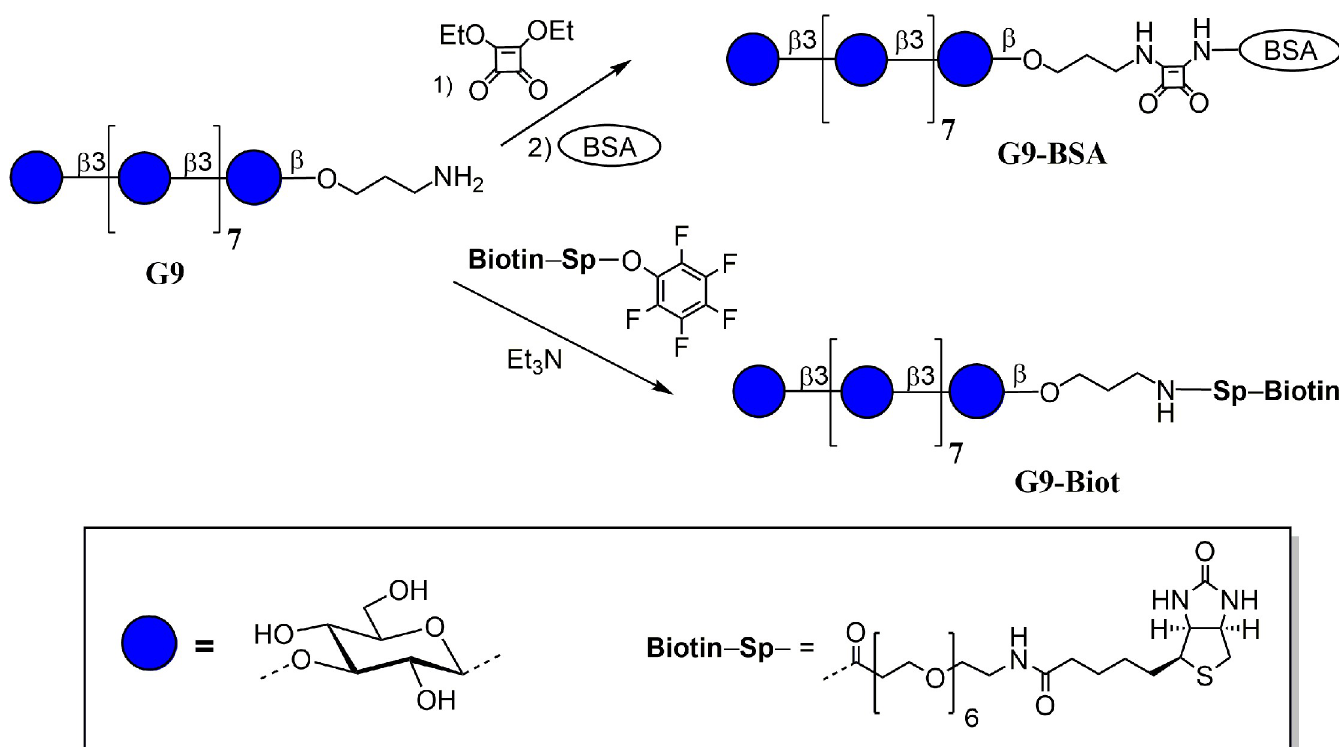
Fig 1. Structure of nonasaccharide G9 and its BSA (G9-BSA) and biotinylated (G9-Biot) conjugates used in mouse immunization and mAb screening; the carbohydrate sequences are represented according to symbol carbohydrate nomenclature [18].